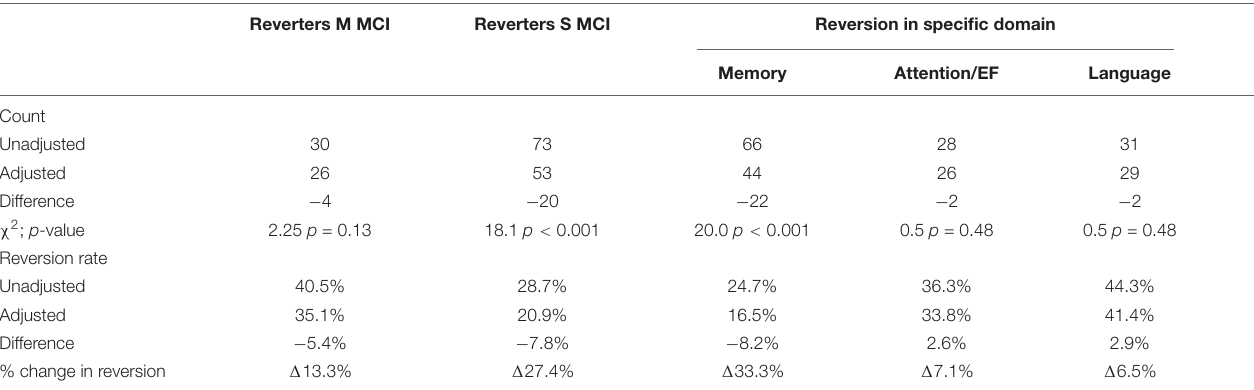
TABLE 4 | Practice effect-adjustment and reversion